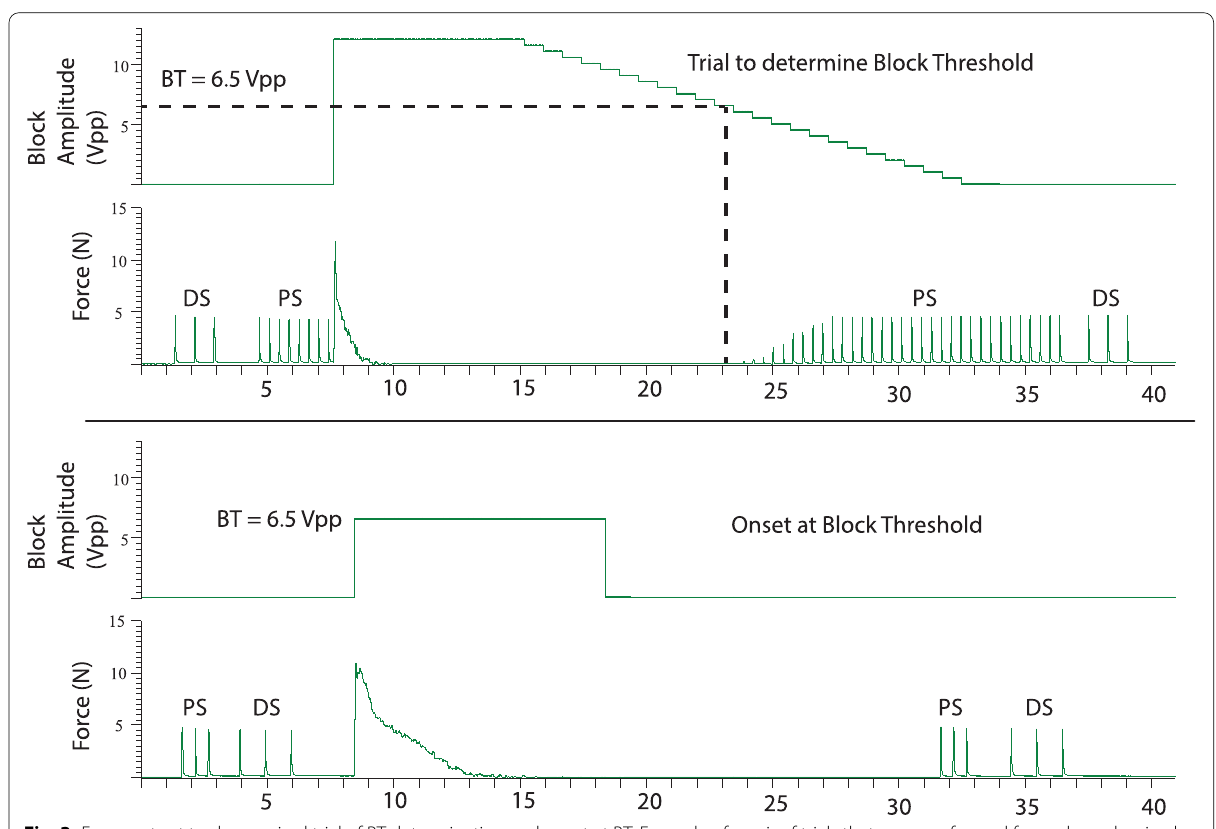
Fig. 3 Force output to show paired trial of BT determination and onset at BT. Example of a pair of trials that were performed for each randomized frequency-waveform combination. For each trial, the upper plot is the blocking amplitude, the lower trial is the force output from the gastrocnemius muscle. See Methods section for